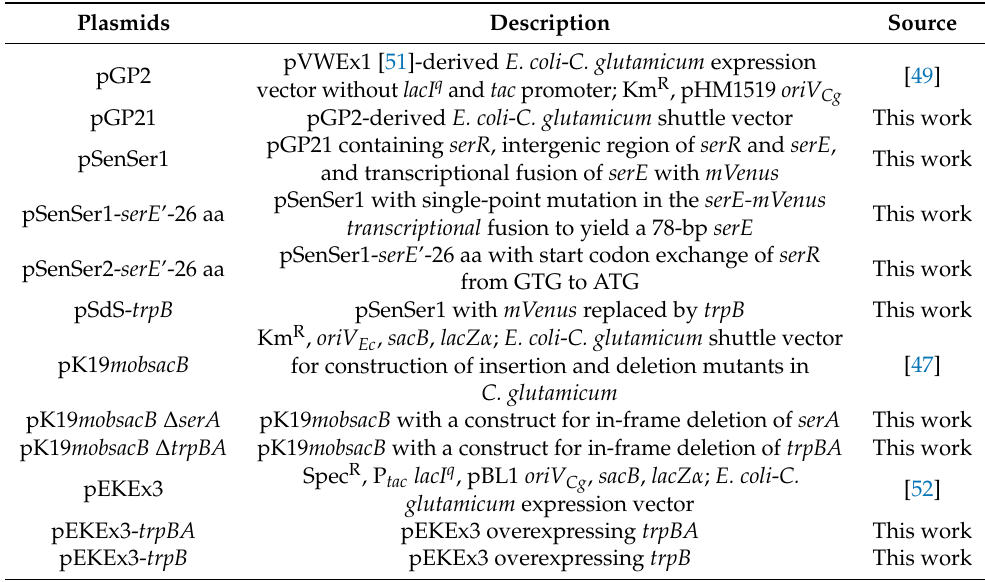
Table 3. Plasmids used in this